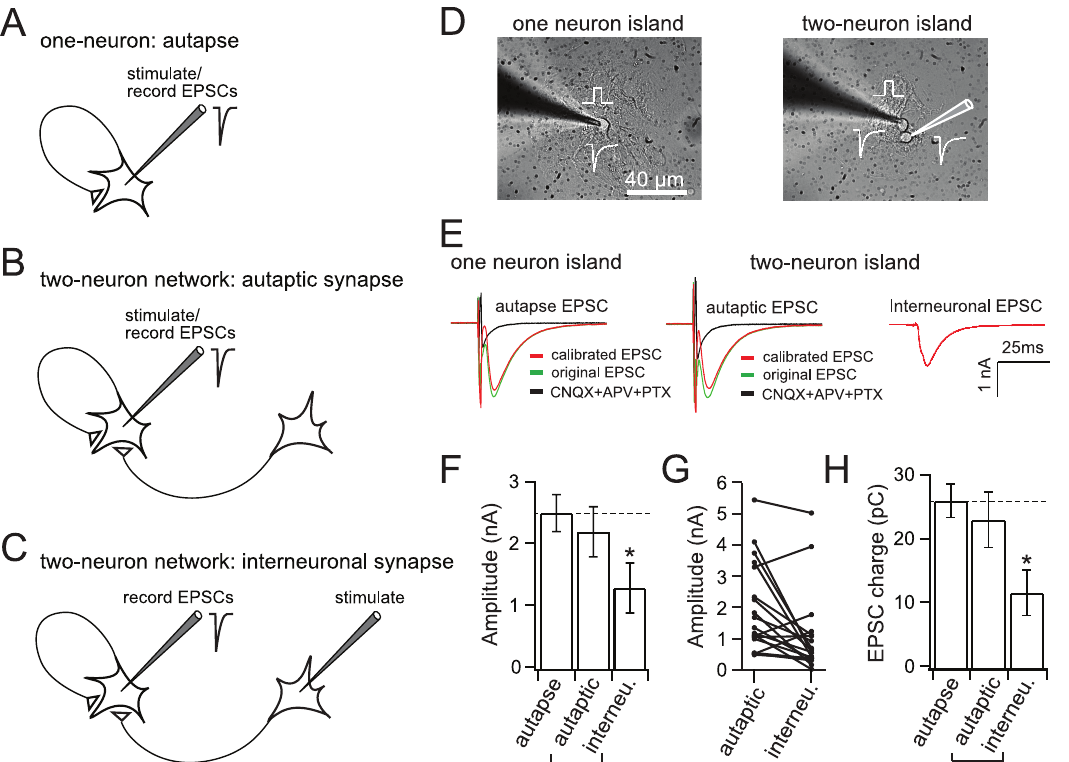
Figure 1. Autaptic synapses have larger EPSCs than interneuronal synapses. (A) Cartoon of an autapse, in which a single neuron growing on a micro-glial island innervates itself, and thus can be stimulated and recorded from at the same time. (B) Recording scheme for autaptic synapses, and interneuronal synapses (C) in two-neuron micronetworks. (D) Image of micro-island cultures consisting of one (left panel) or two (right panel) hippocampal neurons. (E) Representative single EPSC recordings from an autapse (left) and from autaptic or interneuronal synapses in two-neuron micronetworks. The autaptic response (calibrated EPSC) was calculated by subtracting the offset current, due to the action potential preceding the EPSC, from the original EPSC; the offset current was determined by adding CNQX to block AMPA receptors. (F) EPSC amplitude in single neuron autapses (2.5 6 0.3 nA), and in autaptic (2.2 6 0.4 nA), and interneuronal (1.3 6 0.4 nA) synapses in two-neuron micronetworks. Autaptic synapse EPSC amplitude in both one and two-neuron micro-islands is larger than interneuronal EPSC amplitude. (G) Pairwise plot showing autaptic and interneuronal amplitudes recorded from neurons in two-neuron networks: 75% of pairs exhibited higher EPSCs in autaptic synapses than in interneuronal synapses, where interneuronal synapses had 66.9 6 13.1% of the EPSC amplitude of autaptic synapses. (H) EPSC charge in autapses (26.0 6 2.6 pC) and autaptic synapses in two-neuron networks (23.0 6 4.4 pC), is significantly larger than in interneuronal synapses (11.7 6 3.6 pC). Statistical significance was determined by one-way ANOVA and Newman-Keuls post-hoc test. *=p , 0.05, n=18 (autapses), 20 (autaptic synapses in two-neuron micronetworks), 20 (interneuronal synapses in two-neuron networks). All data shown represent mean 6 SEM. (Fig. 1D). We first compared responses to a single action potential (AP) (Fig. 1E). We found that the amplitude of excitatory post- synaptic currents (EPSCs) of autaptic synapses in both single neurons and in two-neuron micronetworks, were significantly larger than those of interneuronal synapses formed between two interconnected neurons (Fig. 1F). This is similar to a previous report in which evoked autaptic currents were enhanced compared to currents recorded from mass cultures [15]. In 75% of pairs (15 out of 20) autaptic synapses exhibited higher EPSCs than interneuronal synapses (Fig. 1G). Interneuronal synapses had 66.9 6 13.1% of the EPSC amplitude of autaptic synapses. The EPSC charge of autaptic synapses, in both single neuron and two- neuron islands, was also significantly larger than that of in- terneuronal synapses (Fig. 1H).